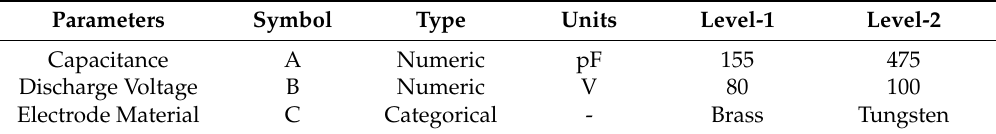
Table 3. Process parameters and range of parameters.